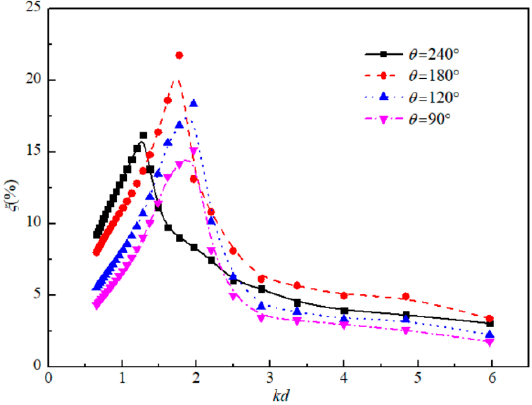
Figure 11. Distribution of conversion efficiency for different baffle wall angle θ .